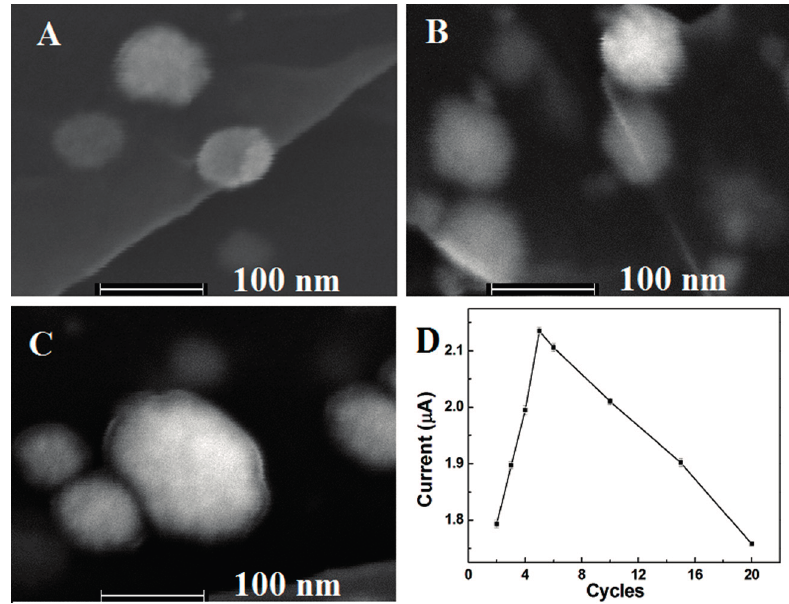
Figure 3. FESEM images of Pt-Au/rGSs hybrid films with different number of scan cycles: ( A ) 3 cycles; ( B ) 5 cycles and ( C ) 10 cycles, at the scan rate of 100 mV·s − 1 ; ( D ) plots of the peak current for the Pt-Au/rGSs/GCE in the presence of 0.1 mM H 2 O 2 vs. different number of electrodeposition scan cycles.